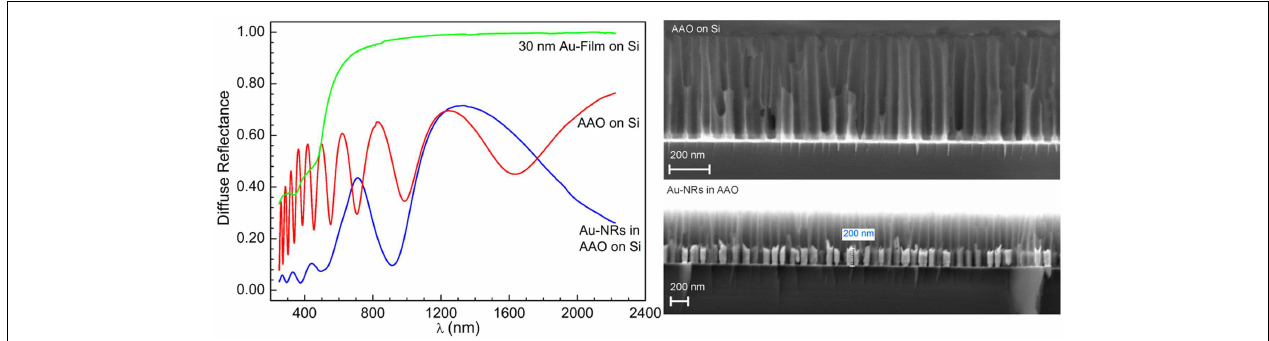
on morphology, dimension, and dielectric environment. These